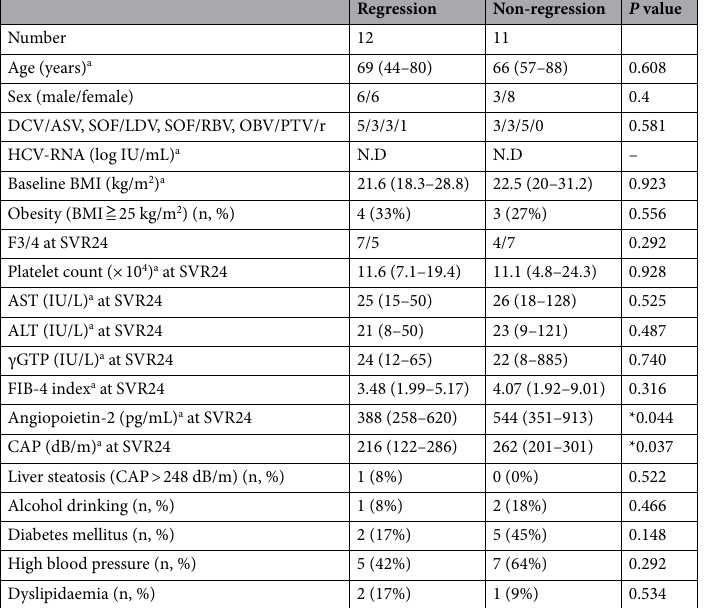
Table 5. Factors associated with non-regression of liver fibrosis stage based on LSM between SVR24 and SVR96 in HCV infected patients with advanced liver fibrosis at SVR24, who were treated with DAAs. HCV hepatitis C virus, BMI body mass index, AST aspartate aminotransferase, ALT alanine aminotransferase, γGTP γ-glutamyl transpeptidase, FIB-4 fibrosis 4, CAP Controlled Attenuation Parameter. a Data are shown as median (range) values. *Statistically significant difference, P <